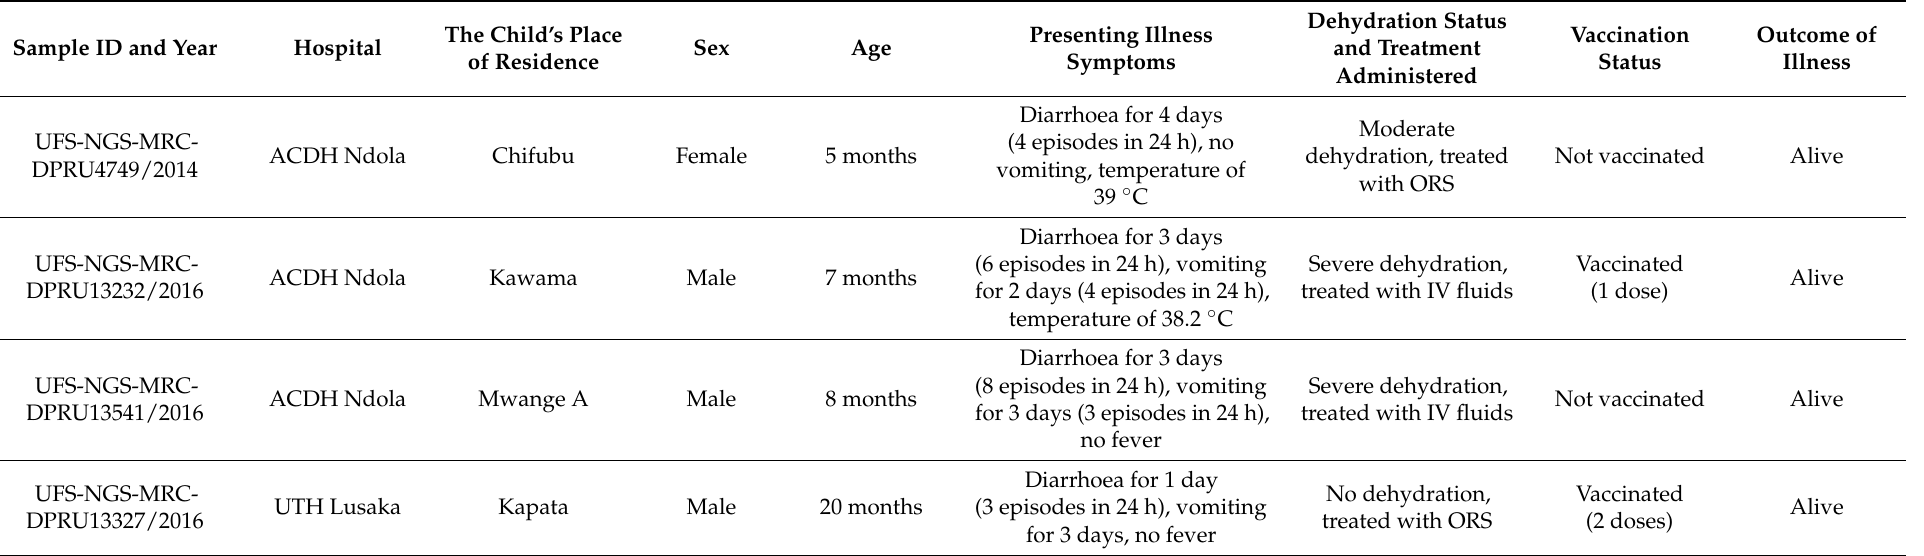
Table 1. Table showing the demographics and clinical profiles of the children from which the study samples were